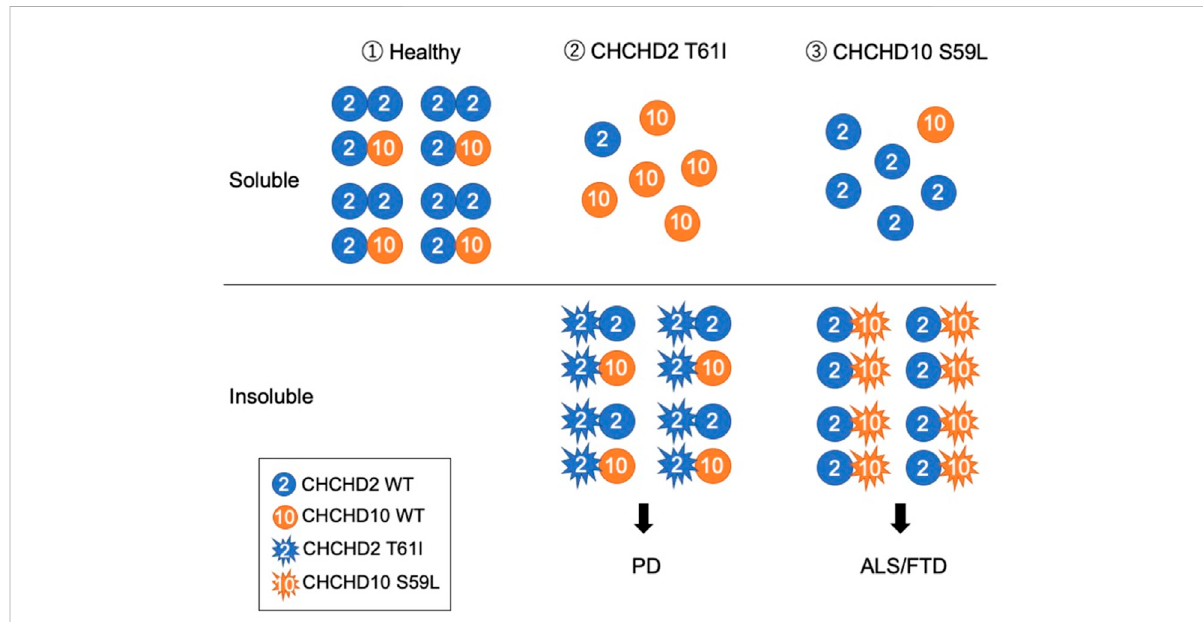
FIGURE 2 Working hypothesis that CHCHD2 T61I and CHCHD10 S59L develop different neurodegenerative diseases. (1) Under a healthy condition, CHCHD2 form a homodimer and a heterodimer with CHCHD10. (2) PD-associated CHCHD2 T61I form aggregates with CHCHD2 WT and CHCHD10 WT and insolubilize them, resulting in the induction of mtISR and the removal of functional CHCHD2 and CHCHD10. (3) ALS/FTD- associated CHCHD10 S59L form aggregates with CHCHD2 WT, resulting in insolubility together. Although the overall expression level of CHCHD10 seems to be lower than that of CHCHD2, depending on the tissue (Uhlen et al., 2015), the pathogenesis of PD and ALS/FTD may diverge, depending on which of CHCHD2 or CHCHD10 are more impaired. Mitochondrial myopathy-associated CHCHD10 G58R, which forms aggregates that do not insolubilize, affects the cristae structure and causes strong mtISR (Shammas et al., 2022). Thus, the existence of a mechanism different from the pathogenesis presented in this hypothesis is also suggested as different disease